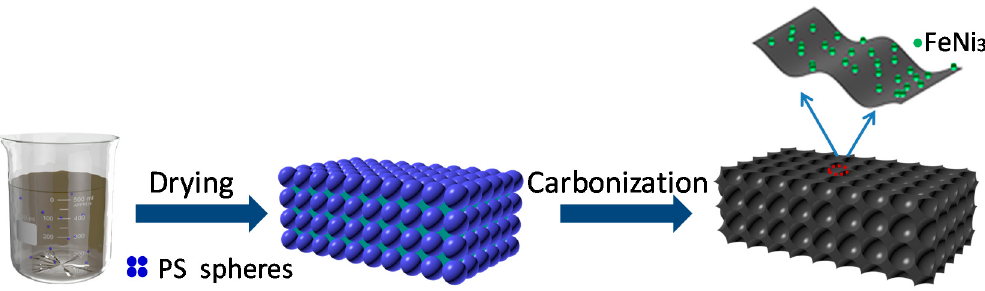
Figure 2. Schematic illustration of the synthesis of 3D honeycomb-like FeNi3@C composites.